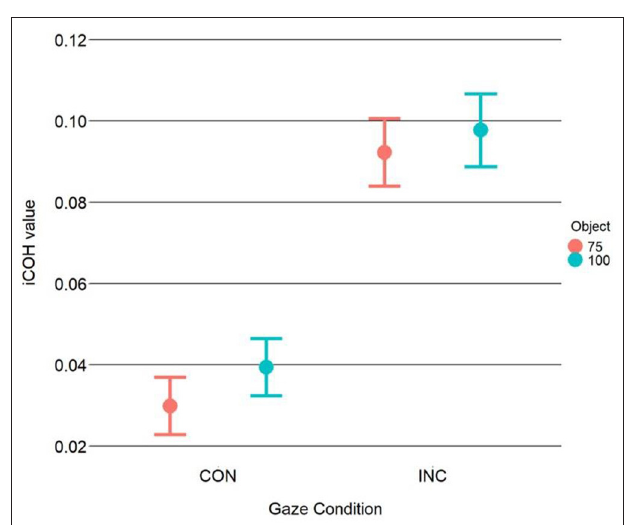
FIGURE 2 | iCOH values as a function of congruency and object type. Analysis of the iCOH values shows significantly more theta synchronization between areas associated with cognitive control and those with attentional orienting for incongruent trials compared to congruent trials. This suggests that more communication is occurring in the theta range between those regions during incongruent trials. Error bars illustrate the 95% CI.